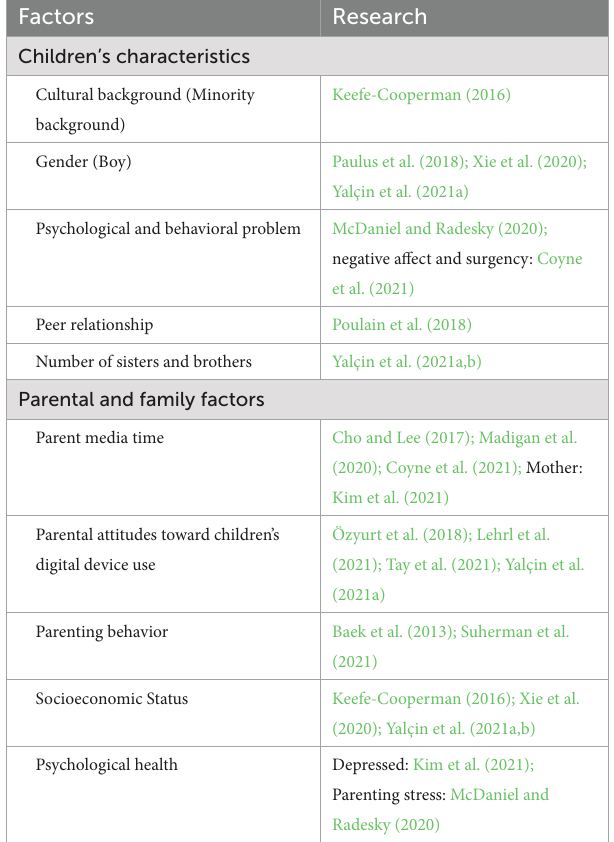
TABLE 2 Digital overuse/Problematic use rates in reviewed studies. TABLE 3 Findings for the factors associated with young digital Citation Country Digital overuse/ Problematic use